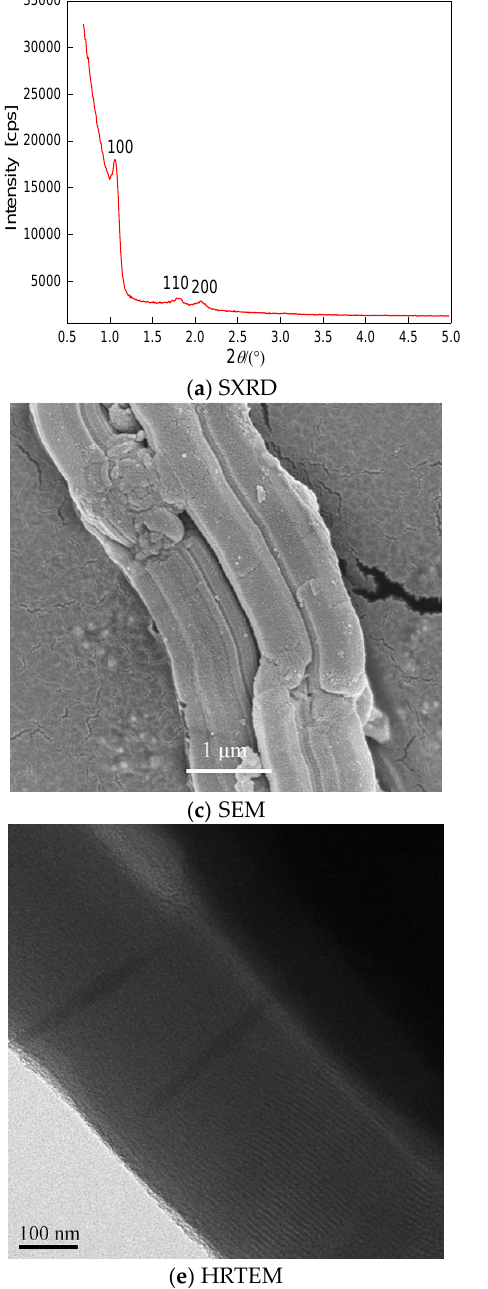
Figure 3. XRD, SEM and TEM and HRTEM photos of